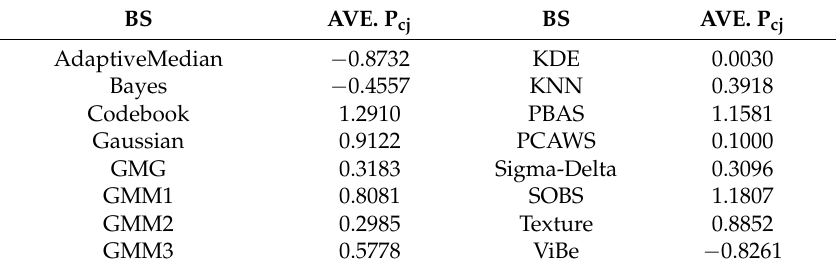
Table 16. Capability of the evaluated BS algorithms to handle camera